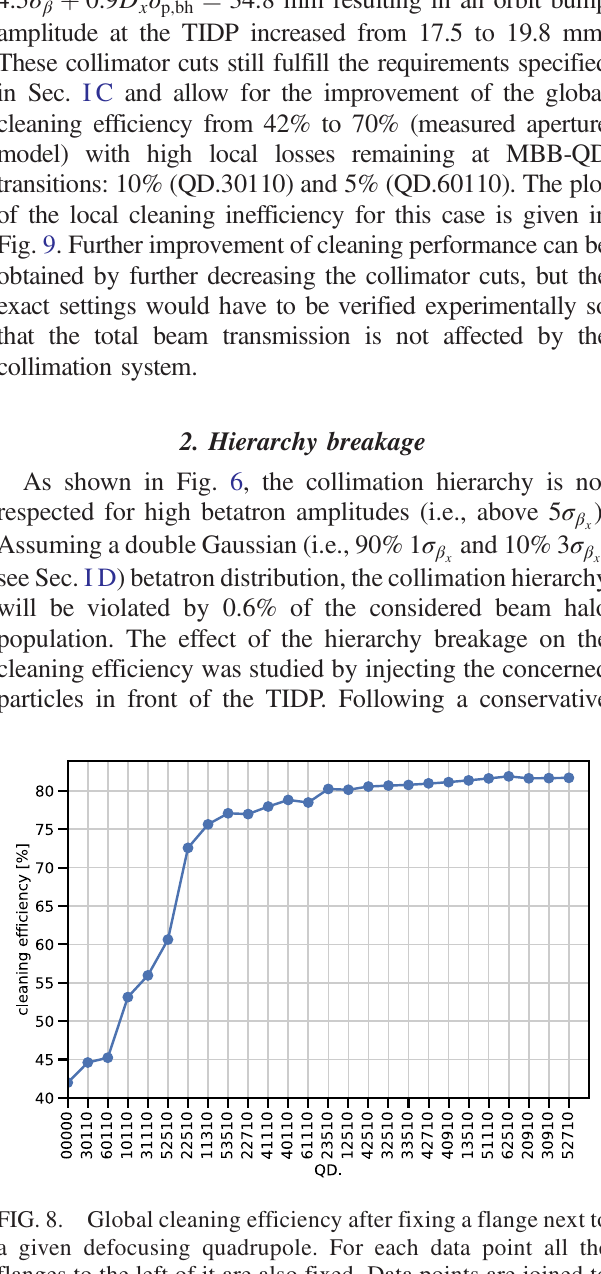
FIG. 7. Local cleaning inefficiency for three aperture models: ideal (top), measured (middle), after LS2 (bottom).